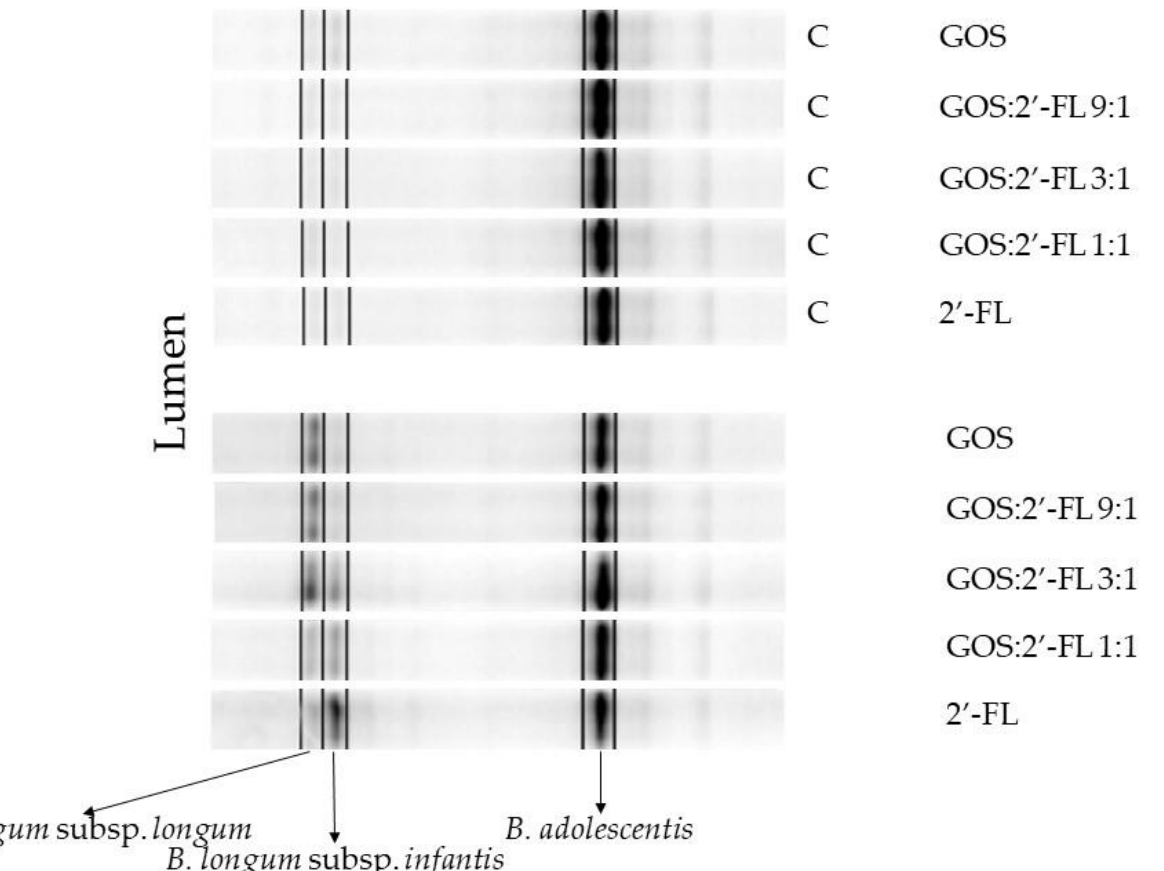
Figure 4. Pearson correlation of DGGE profiles of bifidobacteria in the lumen at the end of the control phase (C) and after 1 week of treatment with different combinations of GOS and 2′ -FL, in the proximal colon of the baby M-SHIME ® .